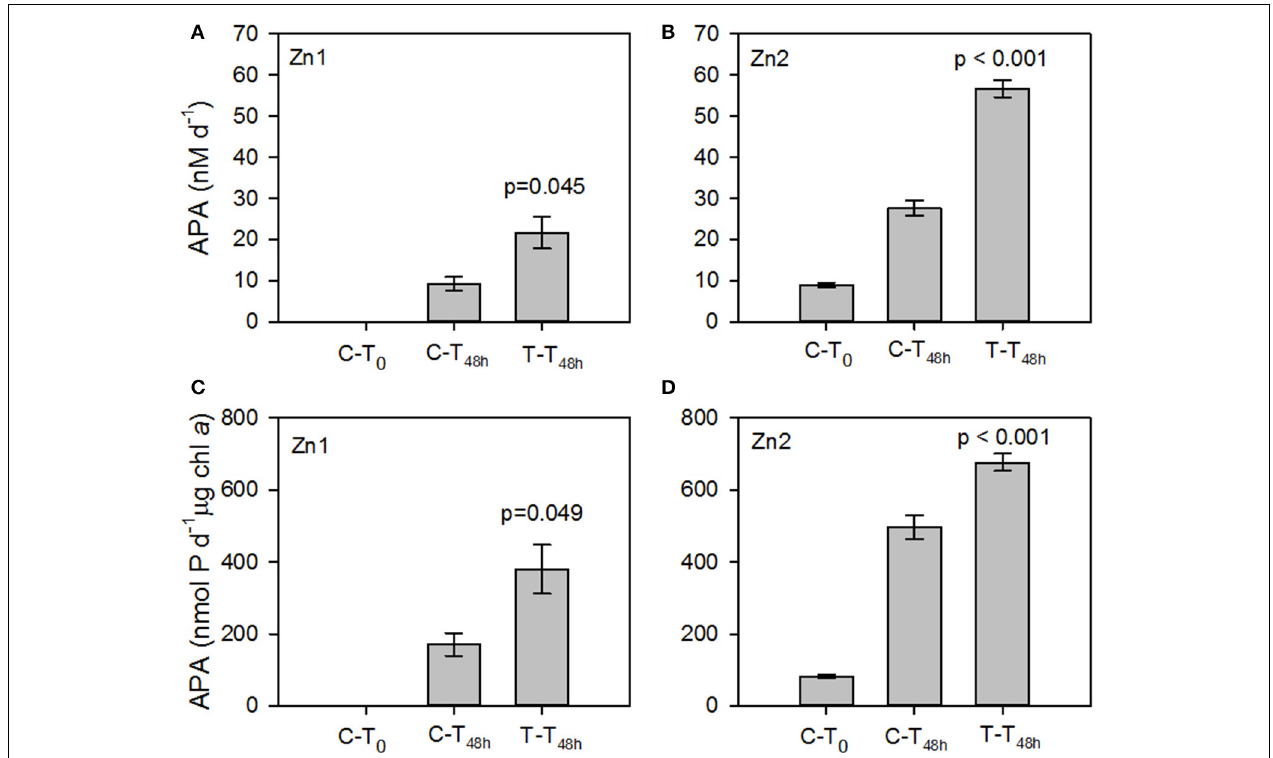
FIGURE 4 | Mean volumetric rates (nM d − 1 , A,B) and chlorophyll a normalized rates (nmol P d − 1 µ g chl a , C,D) of alkaline phosphatase activity (APA) in response to the addition of zinc chloride (Zn) during (A,C) Zn1 at 0.83 ◦ N, 25.2 ◦ W and (B,D) Zn2 at 15.9 ◦ N and 28.7 ◦ W.